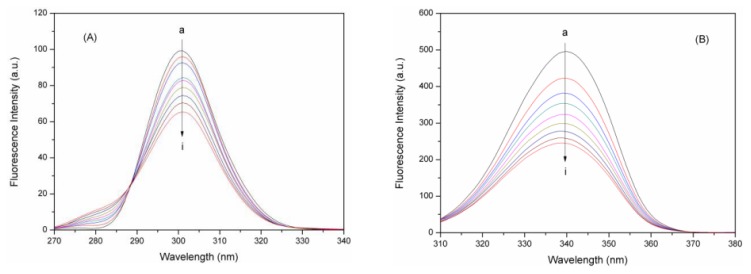
Synchronous fluorescence spectra of BSA with various amounts of eupatorin. (pH 7.4, T = 298 K): (A) Δλ = 15 nm (λex = 240nm, λem = 255–400 nm); (B) Δλ = 60 nm (λex = 240 nm, λem = 300–400 nm). CBSA = 3.0 × 10−7 M; Ceupatorin = 0.0, 2.0, 4.0, 6.0, 8.0, 10.0, 12.0, 14.0, and 16.0 × 10−7 M, respectively.